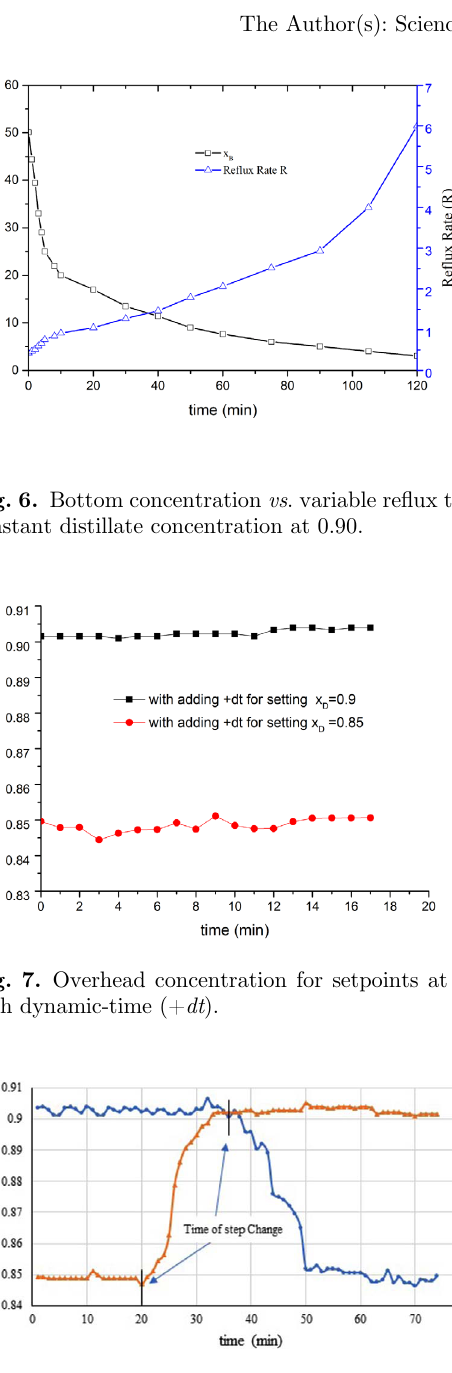
Fig. 8. Overhead concentration disturbance from 0.85 to 0.9 with dynamic-time (+ dt